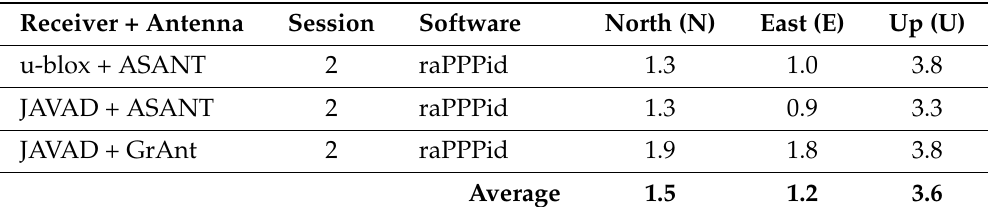
Table 4. RMS values for ambiguity fixed solutions of session 2 (in